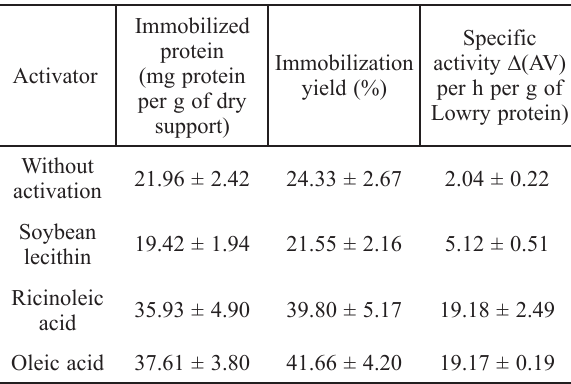
Table 2 – Experimental results obtained in the immobiliza- tion of Lipozyme ® CALB L on Lewatit ® Monoplus MP 64 to study the influence of different activators